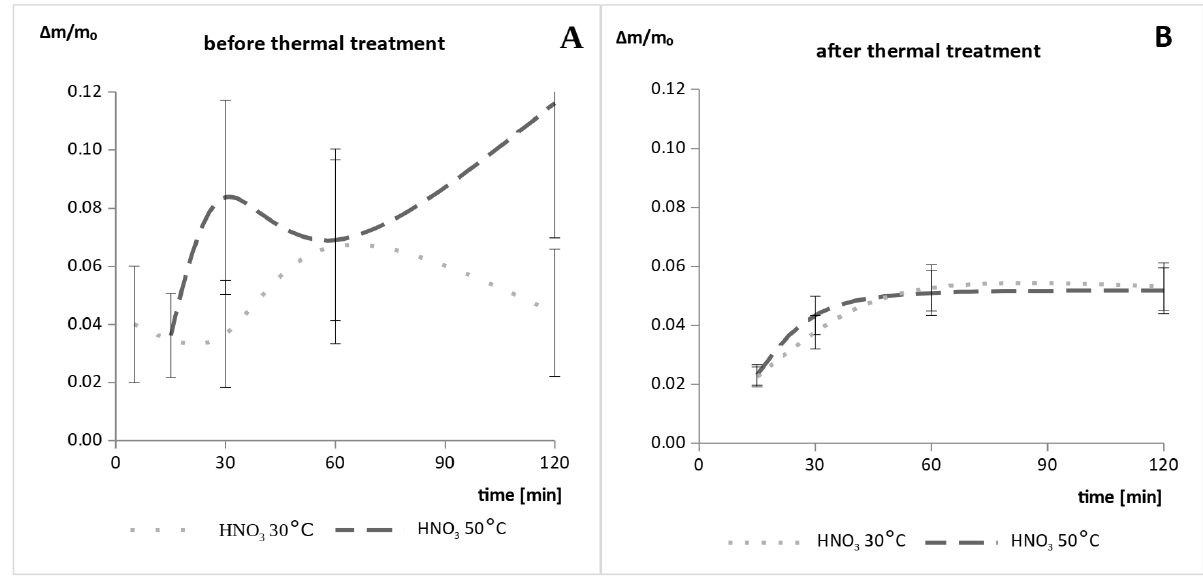
Figure 1. Etching results for samples of the milled thin-film module made of CdTe leached in 3 M HNO 3 at 30 °C and 50 °C ( A ) before and ( B ) after the thermal delamination process.